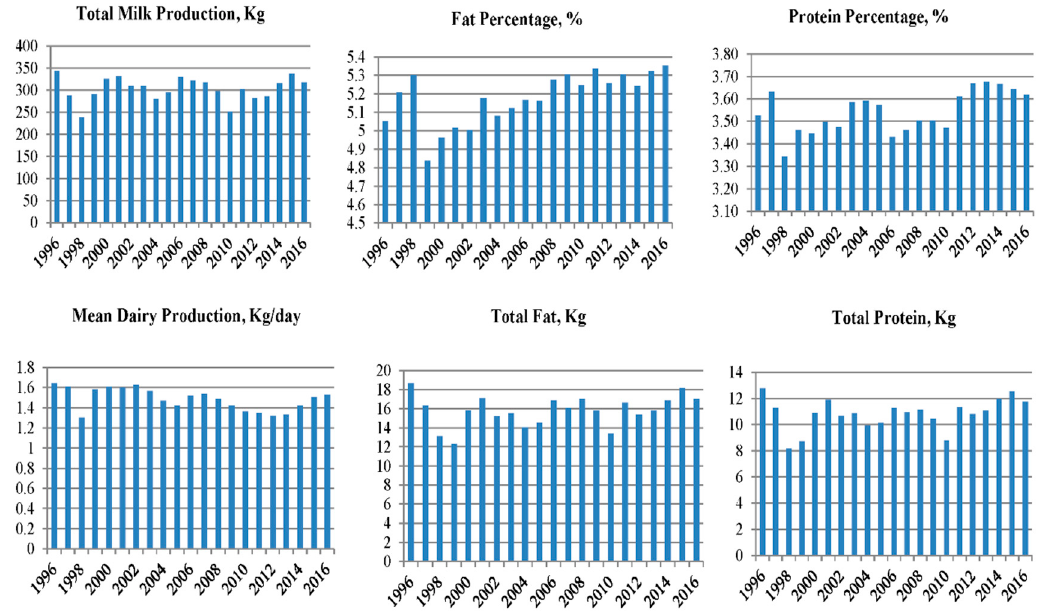
Figure 1. Evolution of the variables studied across parity years.